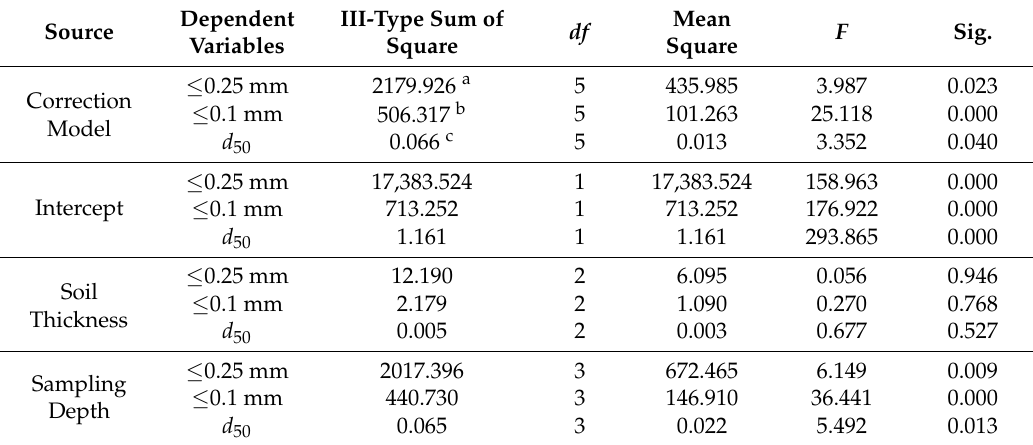
Table 2. Test results of the inter-subject effect after variance